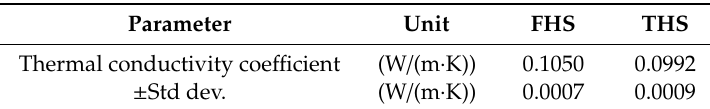
Table 4. Results of thermal conductivity test.